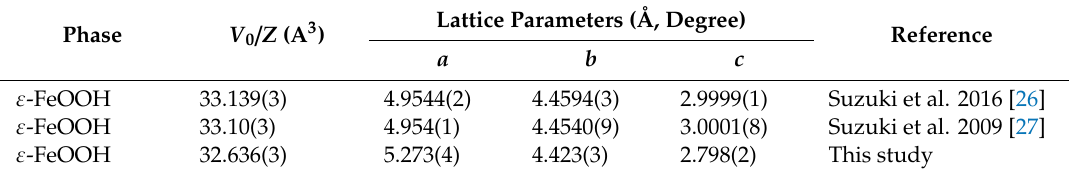
Table 1. Structural data for the synthesized ε -FeOOH under an ambient